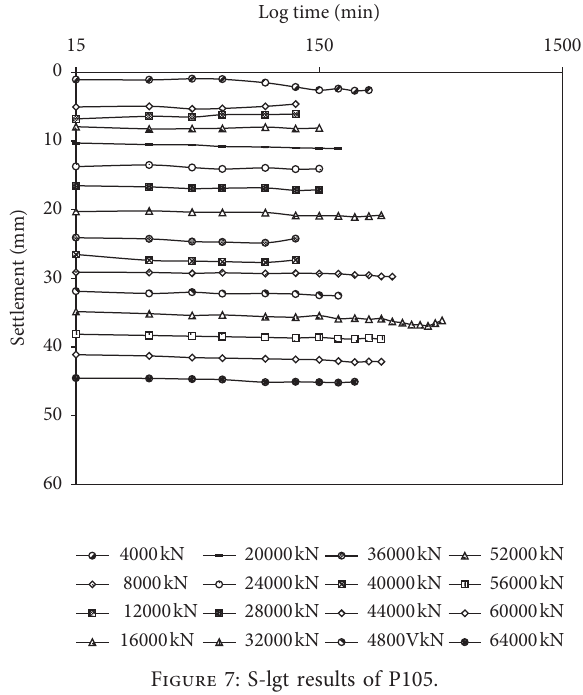
Figure 7: S-lgt results of